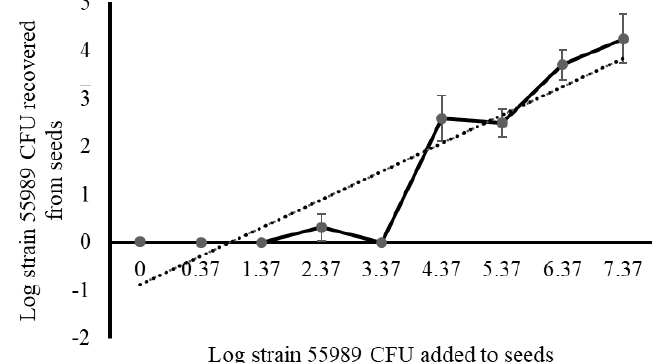
Figure 1. Relationship between the density of E. coli strain 55989 cells exposed to pea seeds and number of cells attaching to the seed surface. Seeds were exposed to di ff erent strain 55989 cell densities for 60 min, where after treated seeds were two times washed prior to analysis for presence of strain 55989 cells that remained attached to the seed surface. Dashed line represents the linear regression line (y = 0.6219x − 0.6588; R 2 =